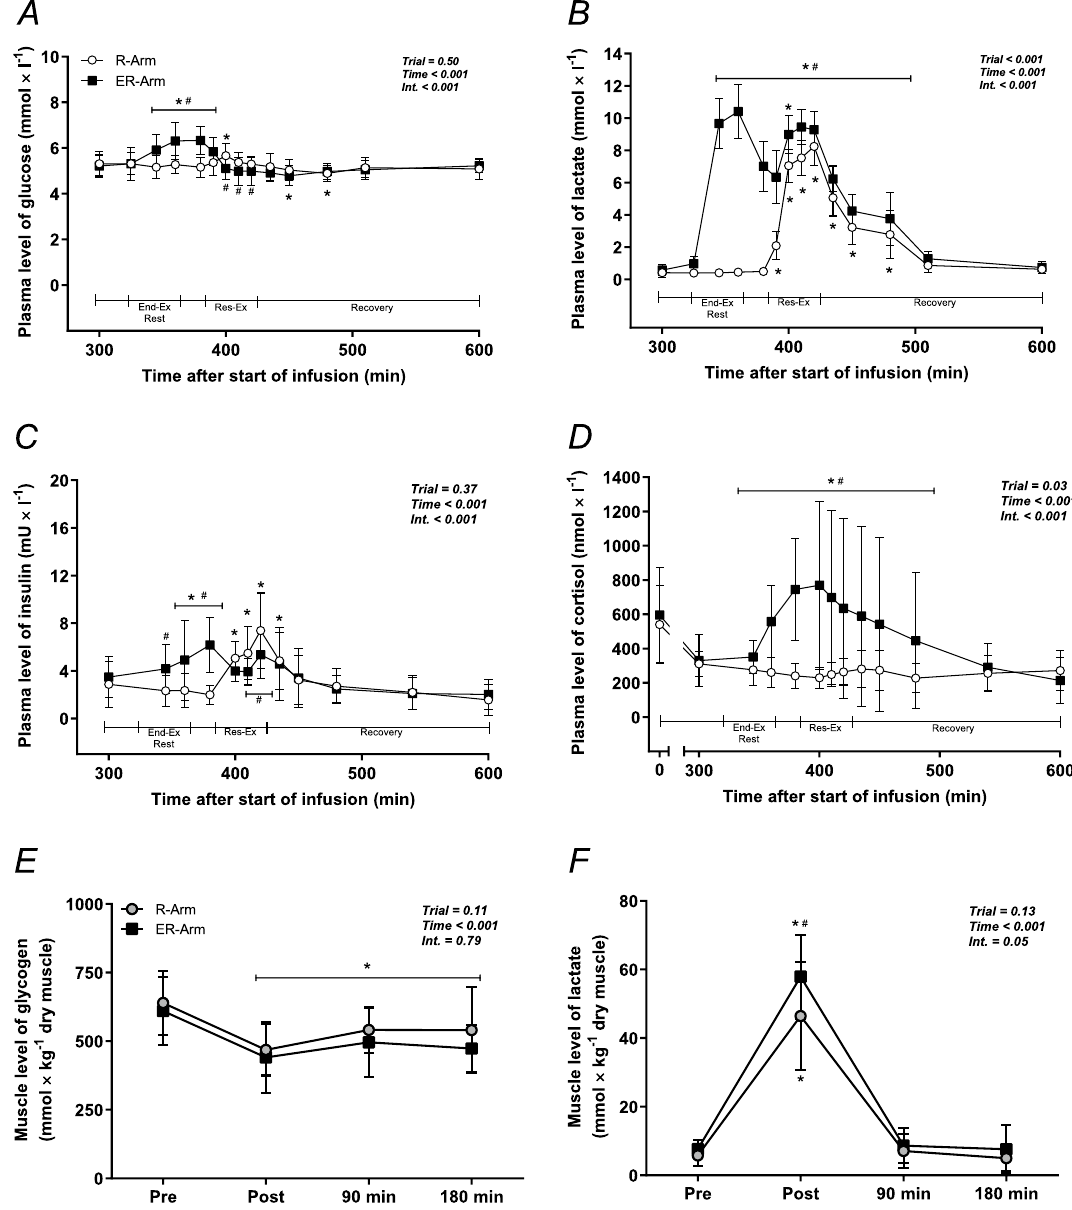
Figure 2. Plasma levels of ( A ) glucose, ( B ) lactate, ( C ) insulin and ( D ) cortisol at rest, during exercise and recovery, as well as muscle levels of glycogen ( E ) and lactate ( F ) at rest and after exercise in the two trials. The values in these graphs are means ± SD for 8 subjects (n = 7 for muscle lactate). * P < 0.05 vs. Rest, # P < 0.05 vs. the R-Arm